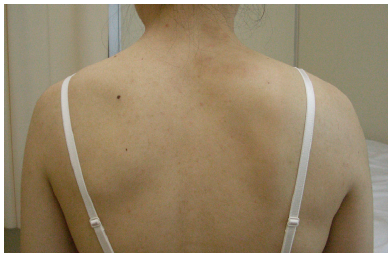
Figure 1: Preoperative photograph showing the deformity of the right scapula. The right scapula showed winging with the arm at the side. An upper interval between the spine and medial scapular border was widened, but the lower one was not.